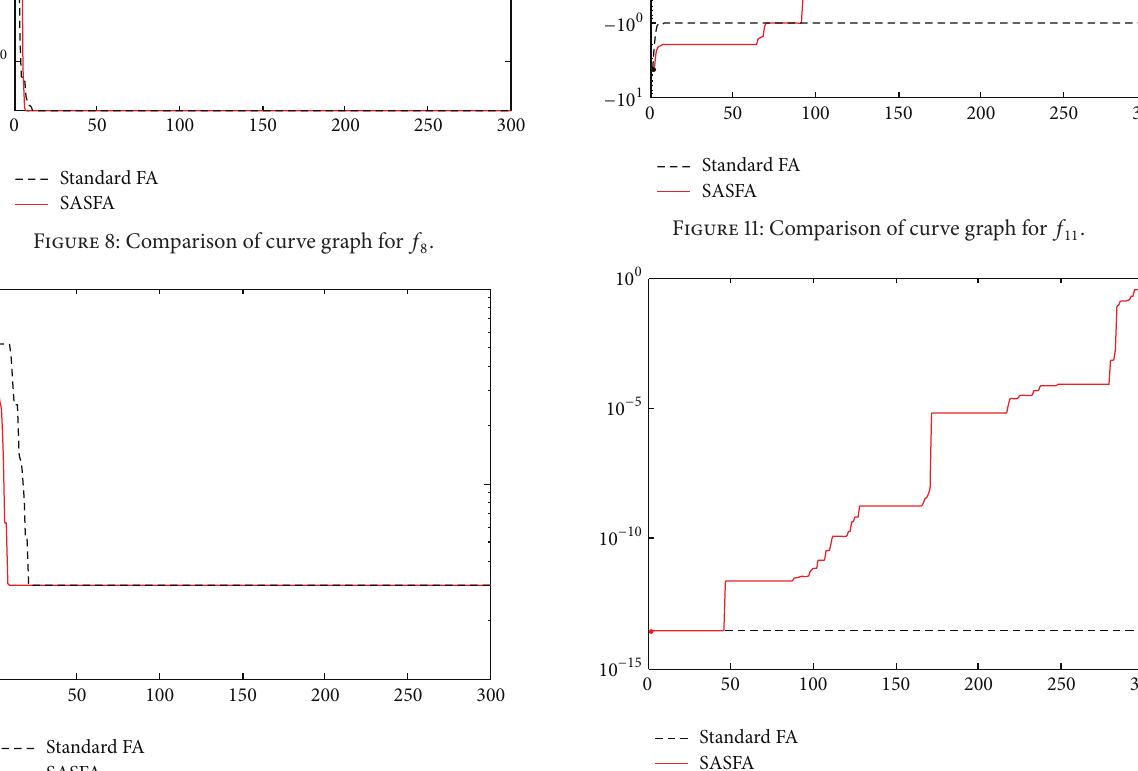
Figure 12: Comparison of curve graph for 𝑓 12